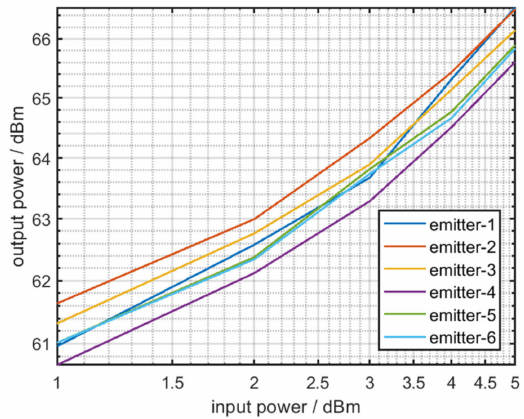
Figure 9. Gain curve of the RF amplifier chain of six distinct